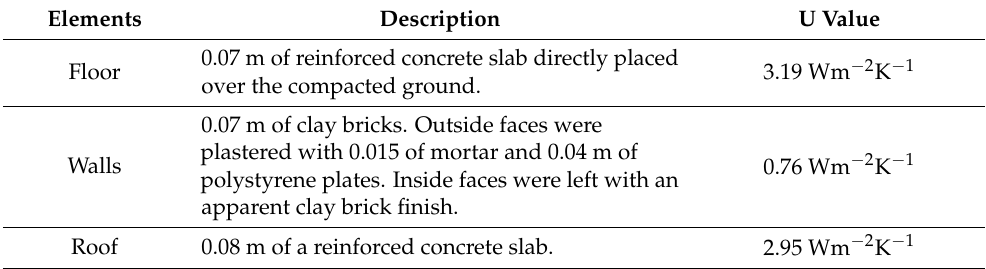
Table 1. Constructive specifications of the experimental cells. Figure 3. Left: distribution of the four experimental cells. Right: photo of the experimental area. Elements Description U Value